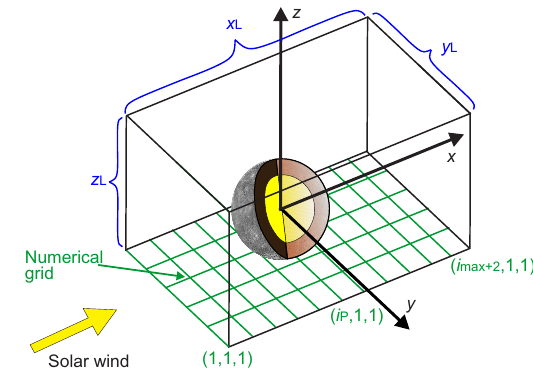
Figure 1. The simulation box contains the planet with its magnetic field. The origin of the coordinate system is in the planet’s center and the x axis is along the unperturbed solar wind